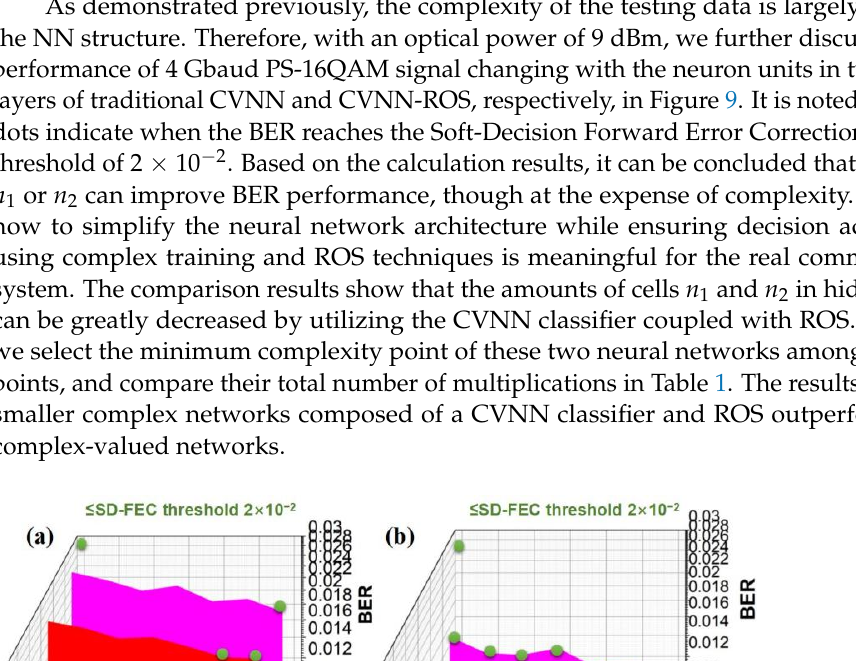
Figure 8. The corresponding BER vs. the training data size for 4-Gbaud PS-16QAM signals using CVNN classifiers and CVNN-ROS classifiers, respectively.